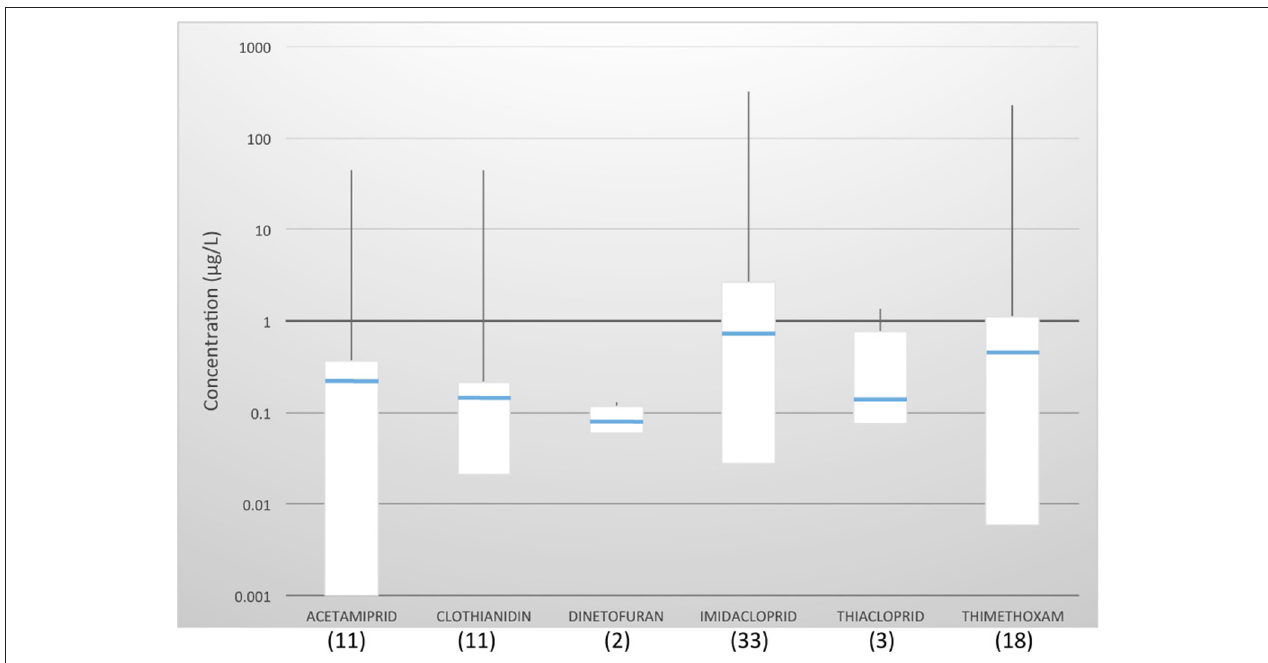
FIGURE 3 | Worldwide survey of neonicotinoid residues in water. The number of surveys reporting each chemical is in brackets. Boxes contain the residues between the first and third quartile; blue lines indicate the geometric mean; vertical lines show the outliers. Sources: see Table